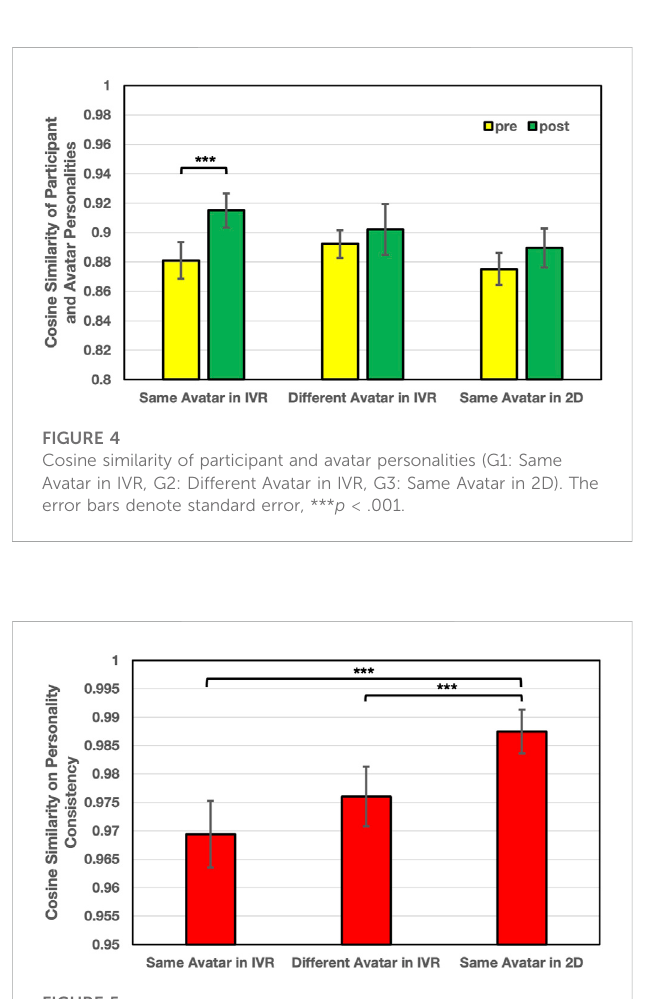
FIGURE 5 Cosine similarity of personalities (consistency of the person) between pre- and post-role-play (G1: Same Avatar in IVR, G2: Different Avatar in IVR, G3: Same Avatar in 2D). The error bars denote standard error, *** p <